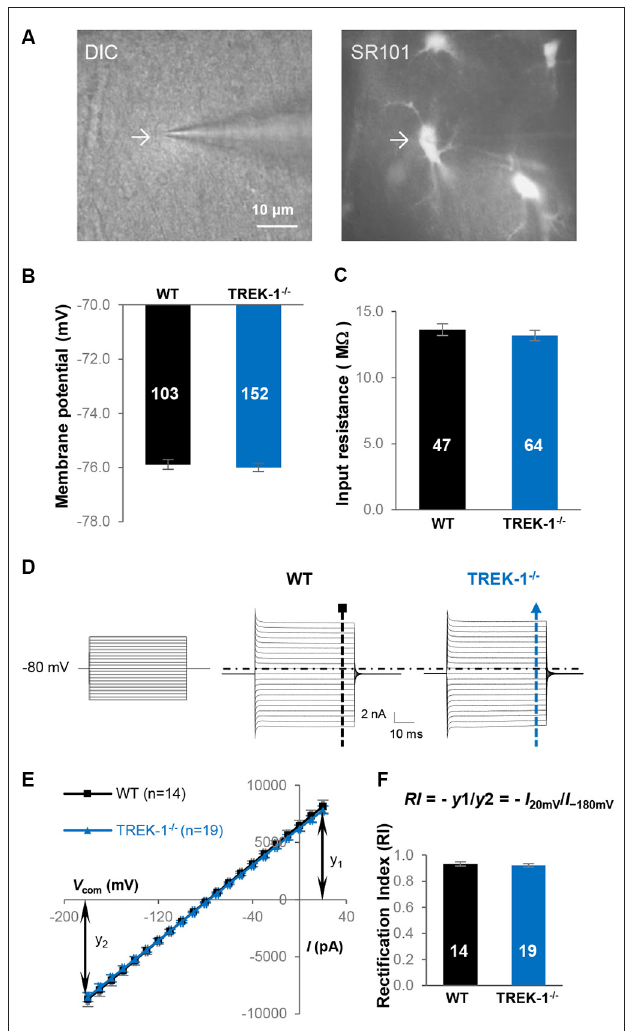
FIGURE 2 | TREK-1 gene deletion does not alter the electrophysiological properties of astrocytes. (A) Identification of astrocyte in hippocampal slices based on cellular morphology and positive SR101 staining in CA1 region. (B,C) Membrane potential ( V M ), and input resistance ( R in ) in WT and TREK-1 − / − astrocytes. (D) Representative astrocyte whole-cell passive conductance from a WT and a TREK-1 − / − astrocyte are shown separately as indicated. The voltage commands used for whole-cell current induction are displayed on the left panel. (E) I-V plots show the averaged current amplitudes from WT and TREK-1 − / − astrocytes. The equation for rectification index (RI) is also illustrated and the resulted RI values are summarized in (F) .